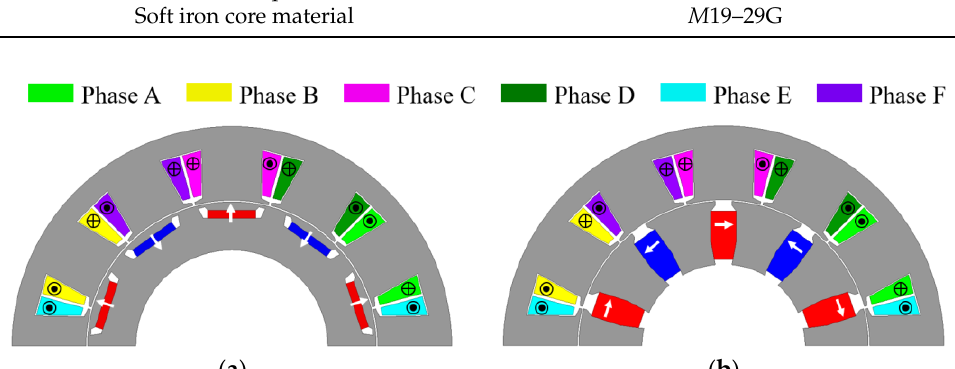
Figure 1. Schematic of 6-phase 12-slot/10-pole ( a ) reported flat-type IPMSM and ( b ) proposed spoke-type IPMSM.